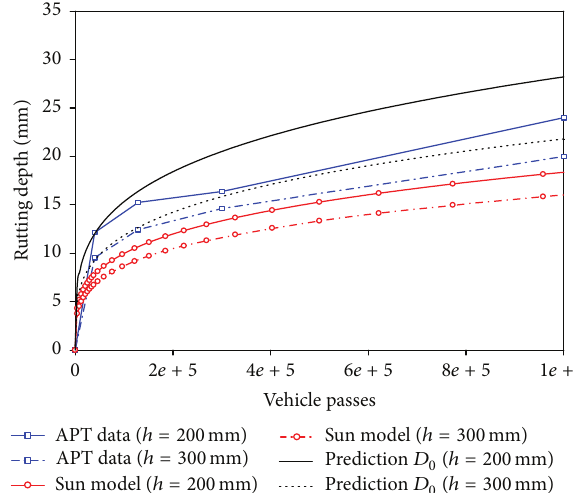
Figure 8: Rutting depth by traffic load (200 mm thick base).